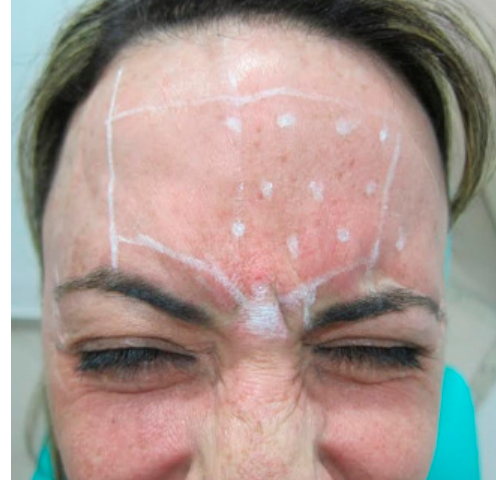
Figure 4. Points delimiting the area of application.